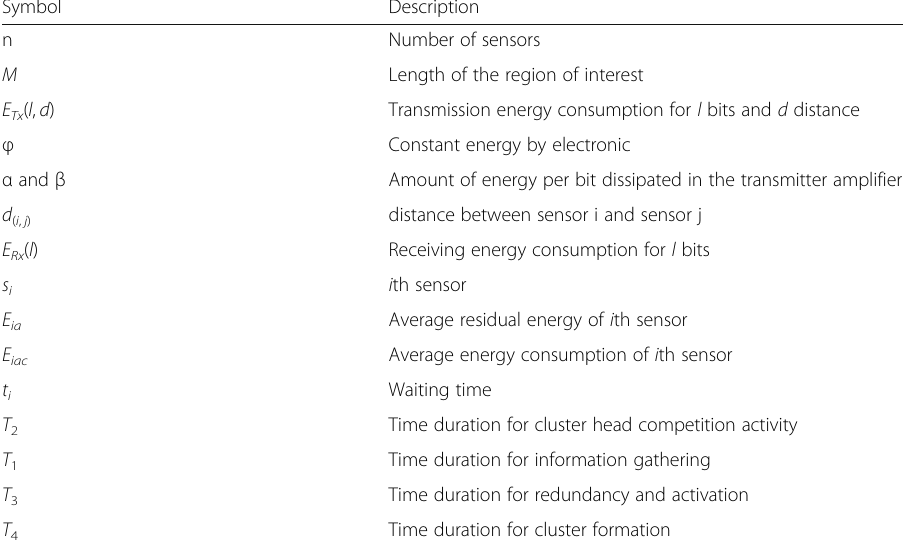
Table 1 Nomenclature Symbol